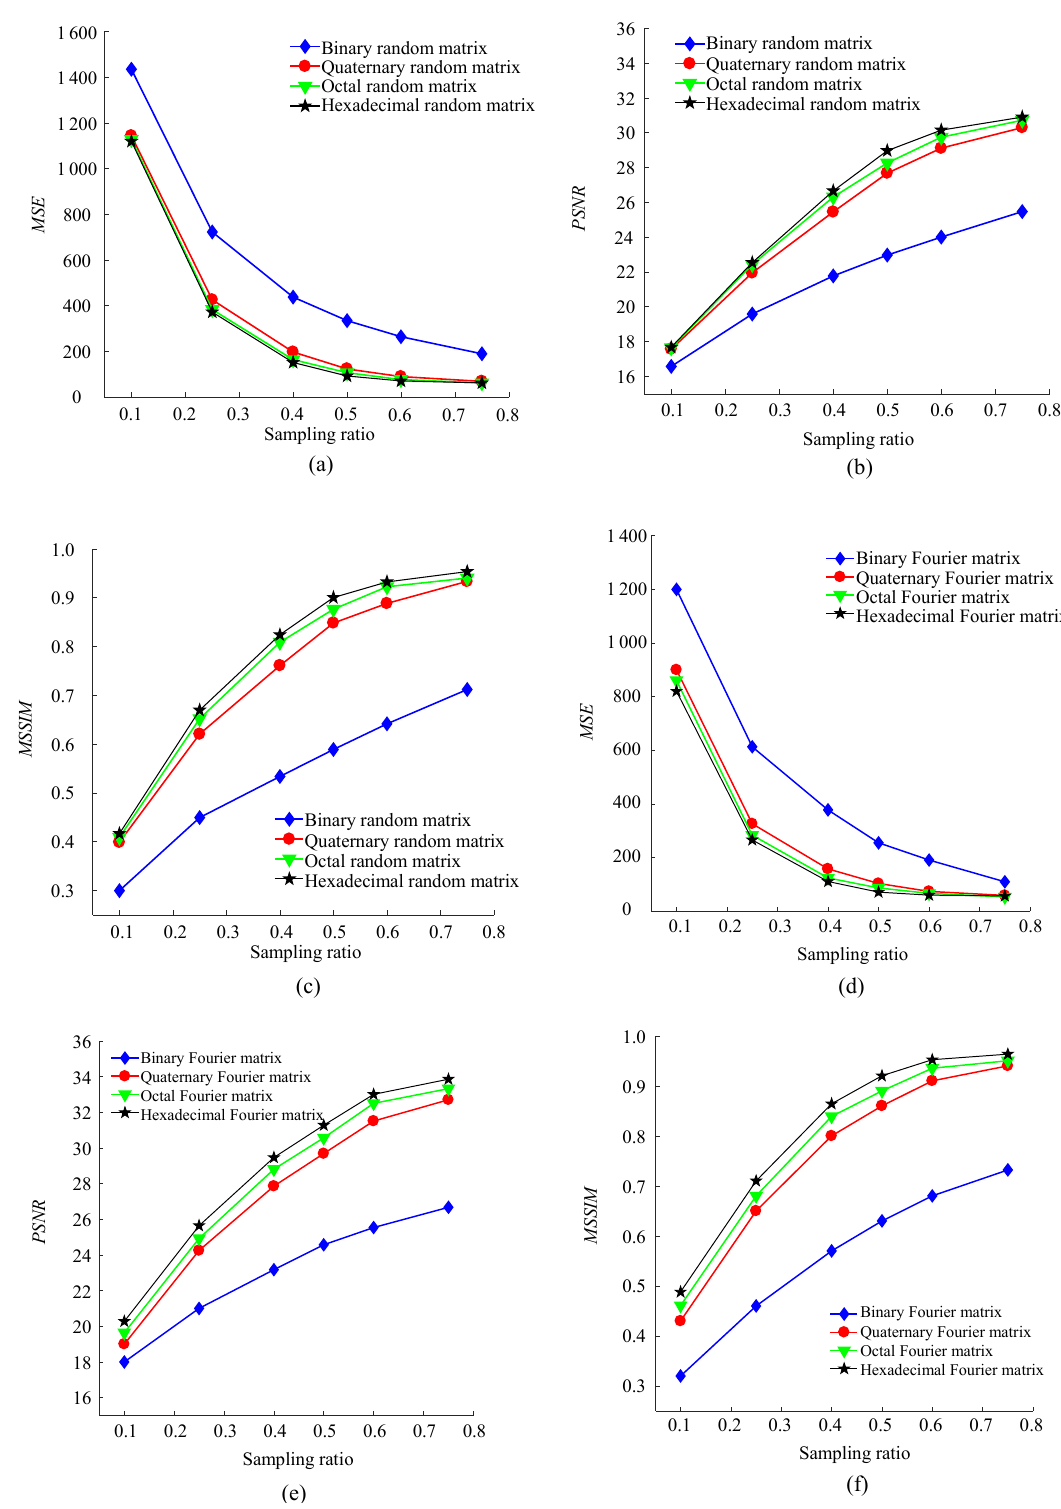
Fig. 9 Corresponding curves of the evaluation indices of compressive SR change. (a) and (d) represent the MSE of the reconstructed image with the changing compressive SR ; (b) and (e) represent the PSNR of the reconstructed image with the changing compressive SR ; (c) and (f) represent the MSSIM of the reconstructed image with the changing compressive SR